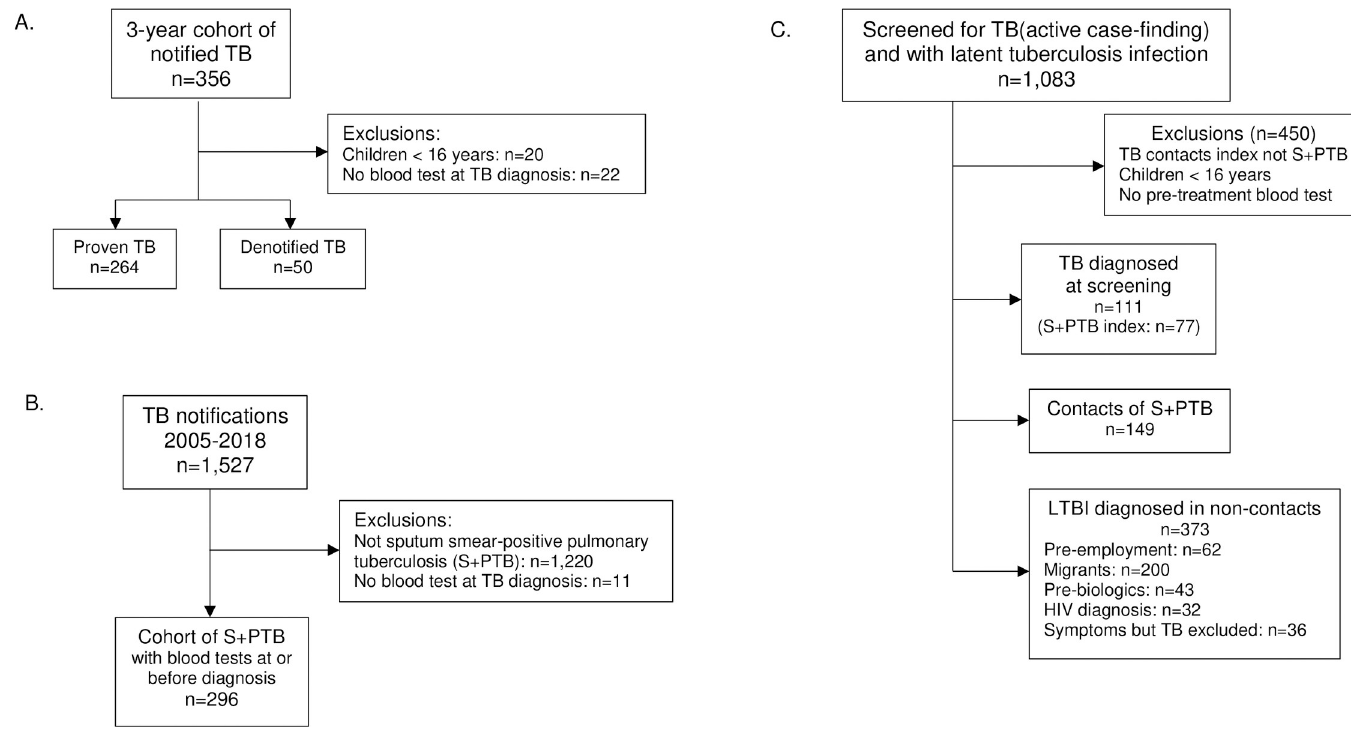
Fig 1. Study populations. Additional demographic details are given in Table 1 and S1 Table in S2 File. A. The cohort of all consecutive TB patients over a 3-year period. B. Selection of a consecutive cohort of patients with sputum smear-positive pulmonary tuberculosis (S+PTB) from all TB patients 2005–2018. C. Active case-finding and description of those with evidence of active or latent tuberculosis infection (LTBI) who were offered either full or preventive treatment respectively.